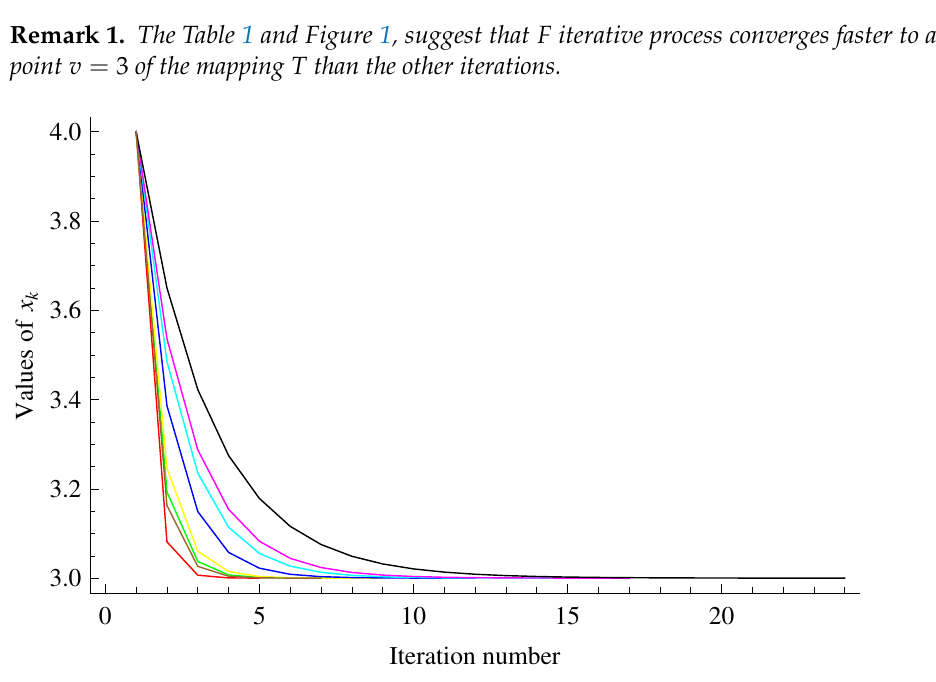
Figure 1. Convergence behaviors of F (red), M (brown), Thakur (green), Abbas (yellow), Agarwal (blue), Noor (cyan), Ishikawa (magenta) and Mann (black) iterative